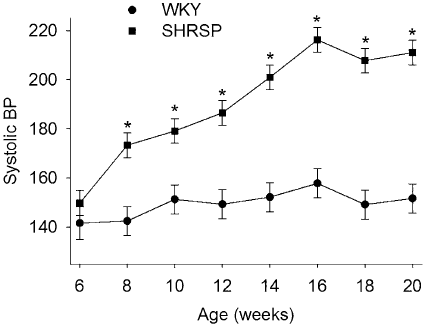
Figure 1. Systolic blood pressure (SBP) in WKY and SHRSP from 6 to 20 weeks of age. Two-way repeated measures ANOVA showed statistical main effects of strain, age, and interaction between strain and age ( p < 0.001 for all, n = 5–7). * p ≤ 0.002 compared to corresponding age in WKYs (Holm-Sidak